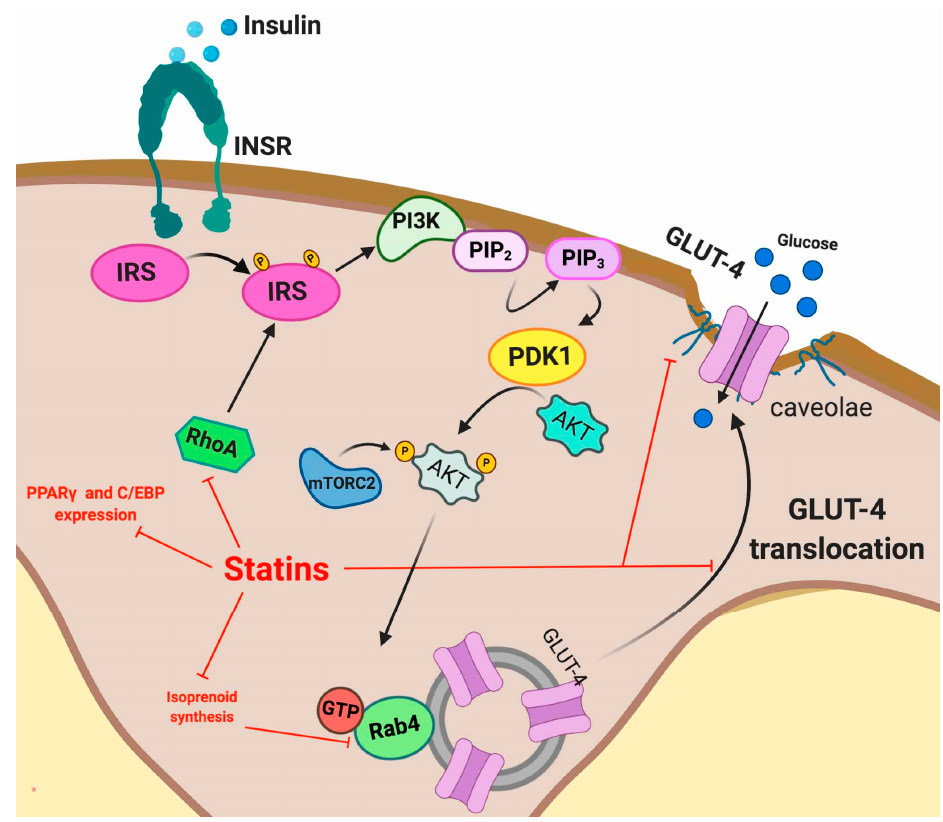
Figure 4. Intracellular actions of statins in adipocytes. Red lines indicate the mechanisms affected by statins.